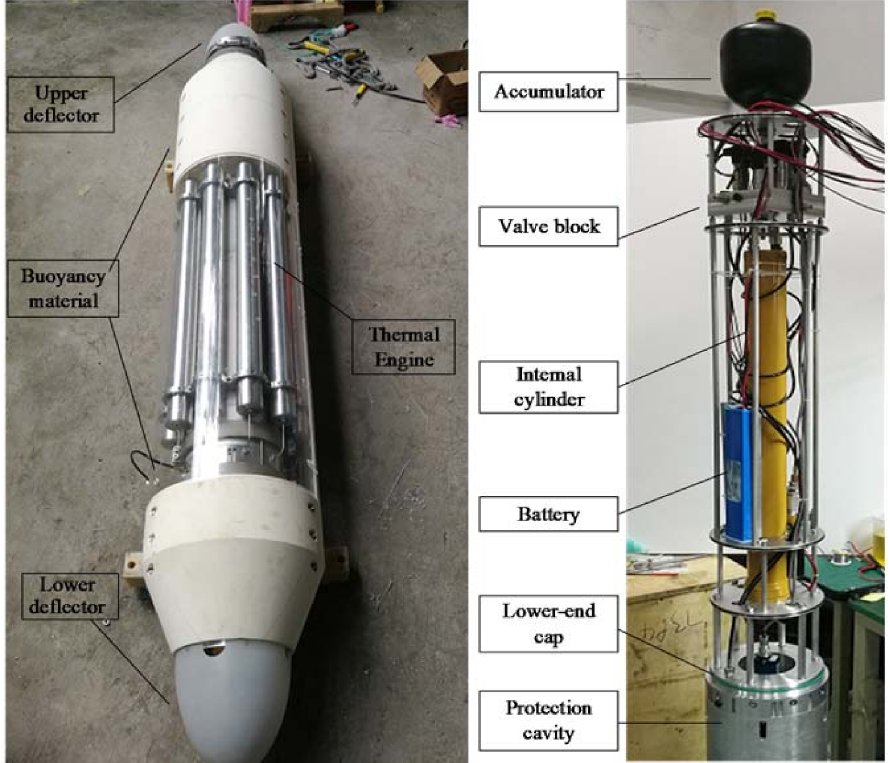
Figure 6. The profiler